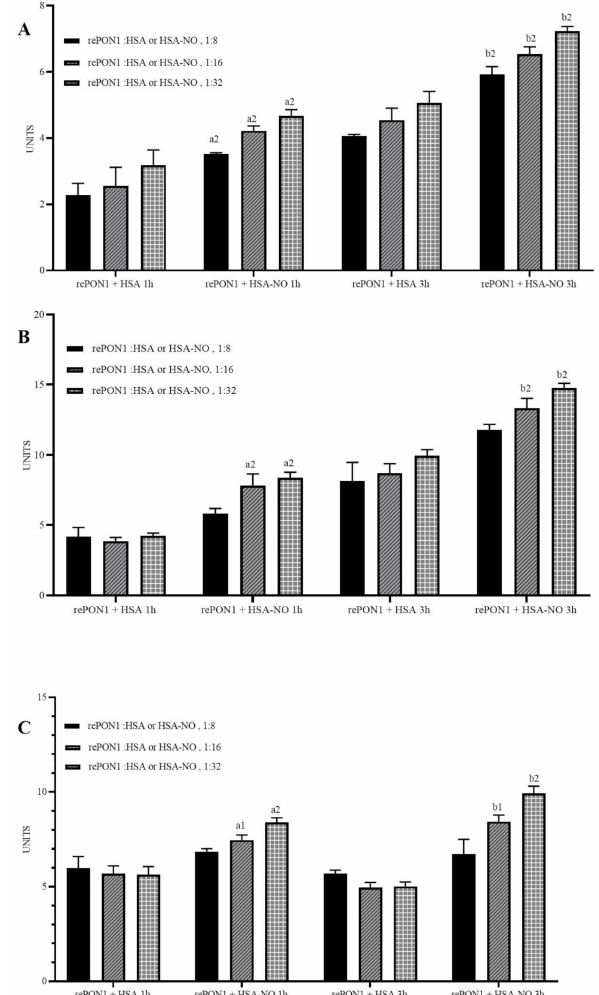
Figure 2. S-nitrosylation of rePON1 with HSA-NO as the donor increases the enzyme’s hydrolytic activities. RePON1 (1.25 µ m) was incubated with different concentrations of HSA or HSA-NO (10, 20, 40 µ m) for 1 and 3 h at 37 ◦ C in HEN buffer (50 mm HEPES buffer, 1 mm EDTA, 0.1 mm neocuproine, pH 7). ( A ) Lactonase activity (5 µ g/mL rePON1). ( B ) Esterase activity (5 µ g/mL rePON1). ( C ) Paraoxonase activity (50 µ g/mL rePON1). Each experiment was repeated separately three times with three replicates each time; a1 or b1 above a bar indicates p < 0.05 relative to rePON1 incubated with HSA for 1 and 3 h, respectively; a2 and b2 = p < 0.0001. Statistical analysis by one-way ANOVA and GraphPad prism